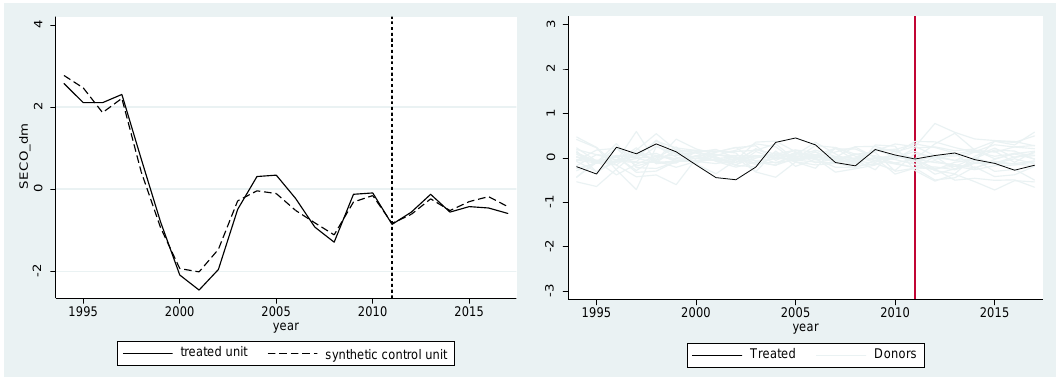
Figure 6. Outcome for Vaud: Demeaned SC and unemployment rate, including all pre-treatment variables as